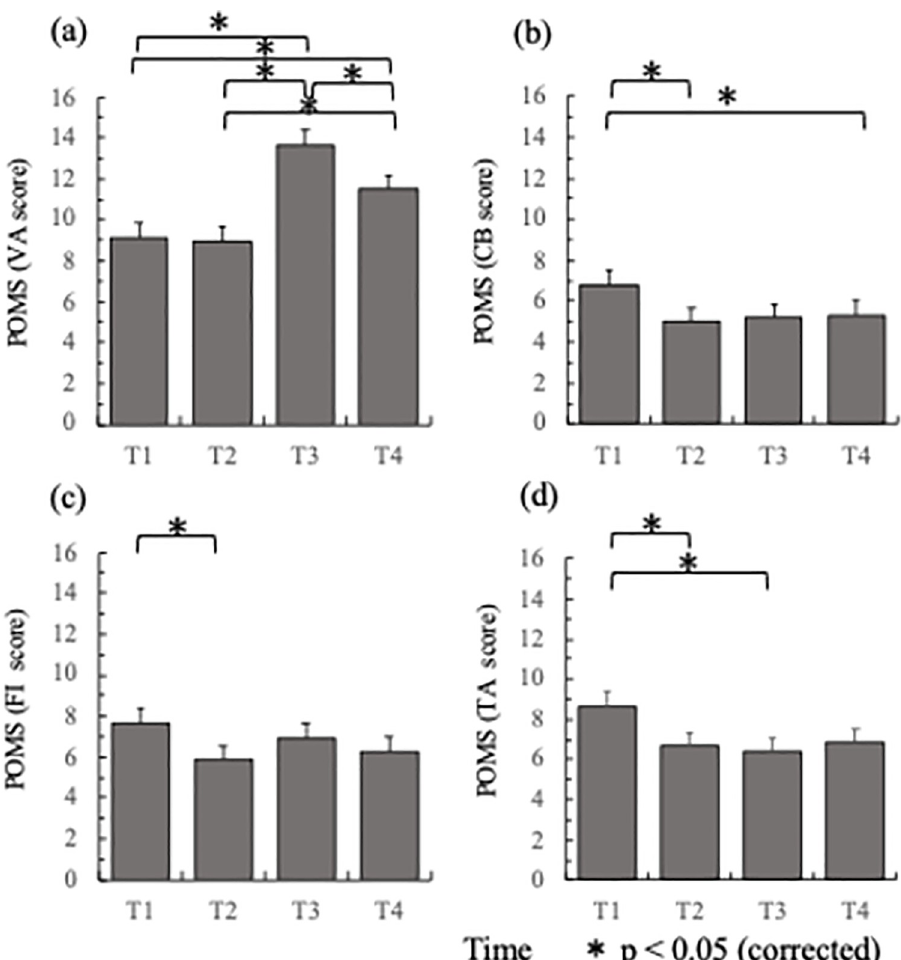
Fig 1. POMS scores (averages) across time. (a) Vigor-Activity (VA), (b) Confusion-Bewilderment (CB), (c) Fatigue- Inertia (FI), and (d) Tension-Anxiety (TA). T1: one month before departure overseas, T2: one day before departure, T3: the day of arrival back in Japan, and T4: 2–4 weeks after their return. The asterisk ( � ) indicates statistically significant pairwise differences (p < 0.05 level), corrected for multiple comparisons using the Bonferroni method. Error bars indicate one standard